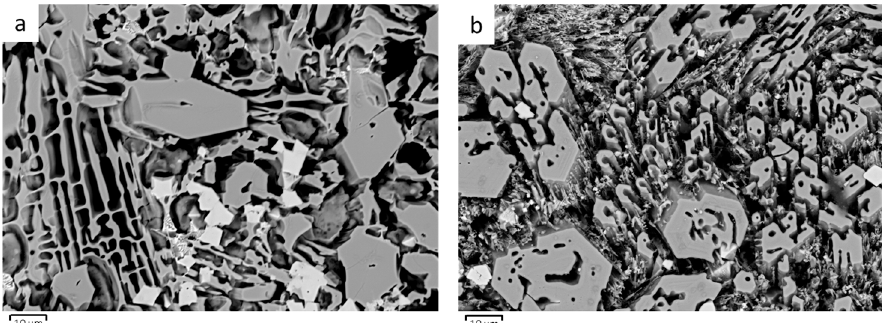
Figure 9. Deep-etched BSE-SEM images of ( a ) as-received and ( b ) heat-treated samples.